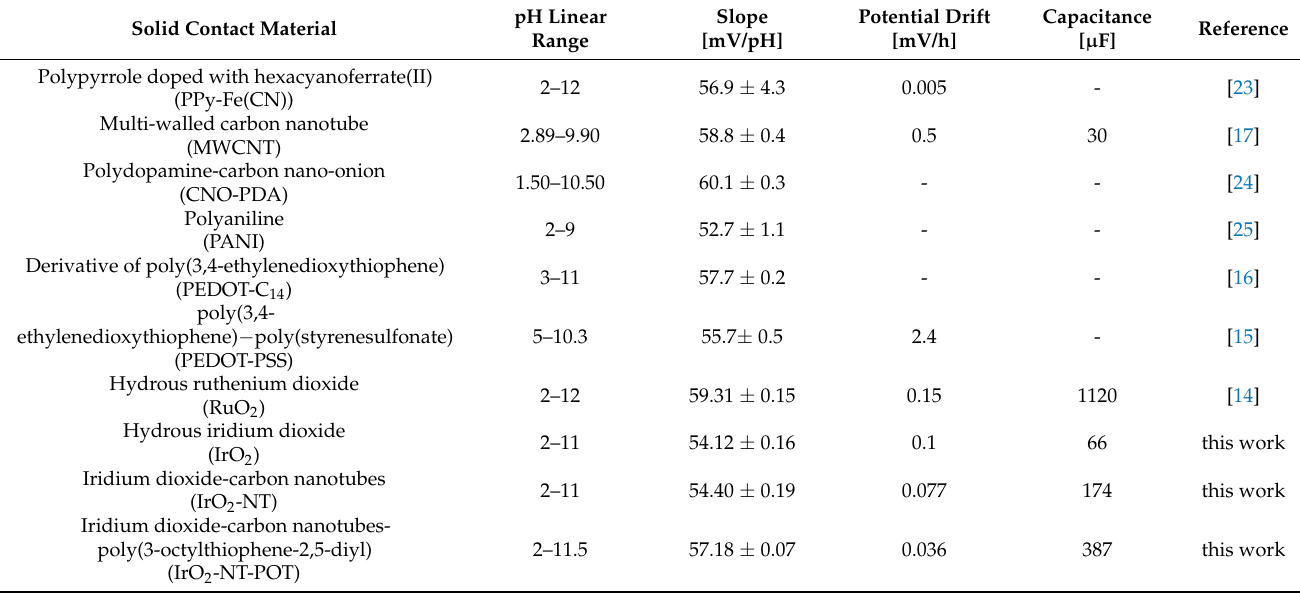
Table 3. Electrical and potentiometric parameters compared for a group of hydrous iridium dioxide- contacted electrodes with other pH-selective solid-contacted